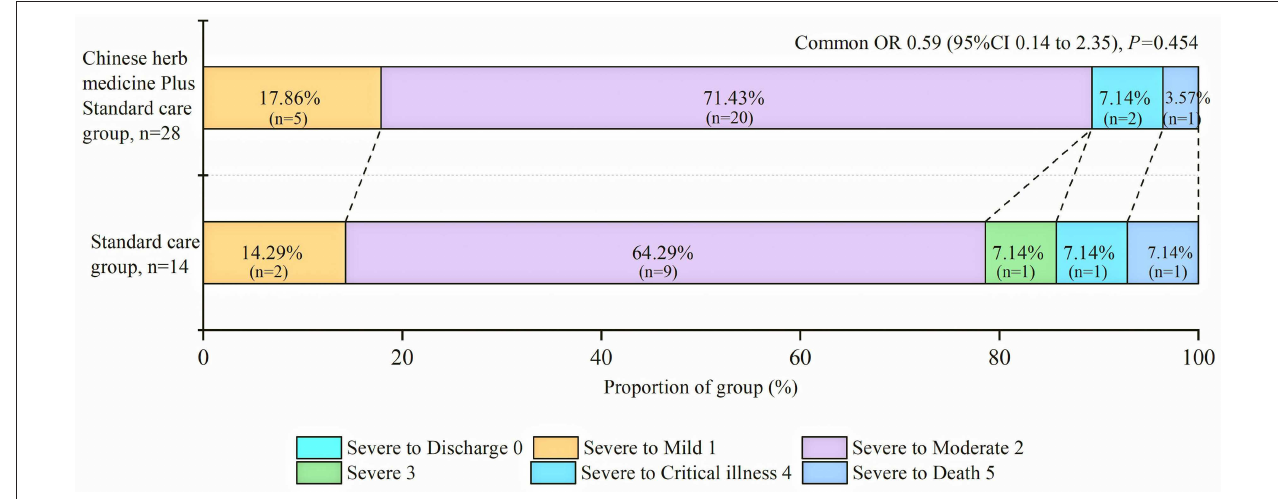
FIGURE 1 | Distribution of COVID-19 severity score at 7 days. OR = odds ratio. The figure denotes scores on the COVID-19 severity scale for patients in the Chinese herbal medicine plus standard care group and the standard care alone group. Scores on the COVID-19 severity scale range from 0 = discharge to 5 = death. A difference between the Chinese herbal medicine plus standard care group and the standard care group was noted in the overall distribution of scores, favoring the Chinese herbal medicine plus standard care group (common odds ratio for improvement of 1 point on the COVID-19 severity scale, 0.59; 95% confidence interval (CI), 0.14–2.35).